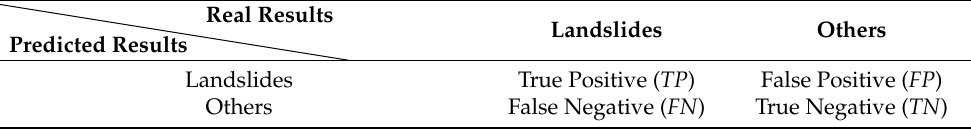
Table 2. Confusion matrix of predicted and real results.